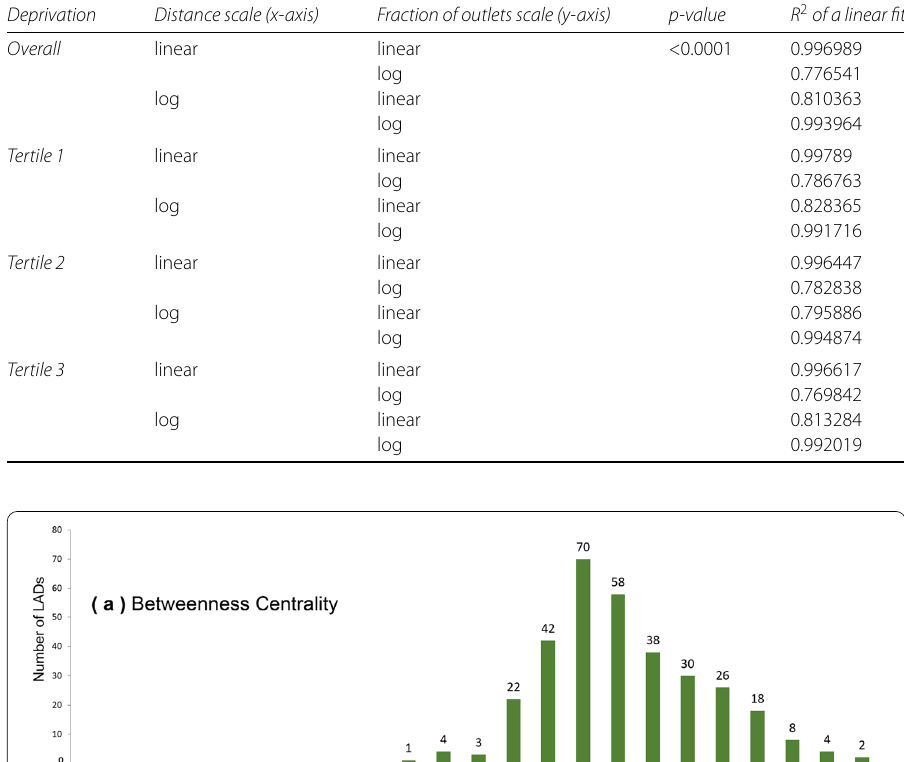
Table 6 Fits across levels of deprivation and scaling of the axes Deprivation Distancescale(x-axis) Fractionofoutletsscale(y-axis) p-value R 2 ofalinearfit Overall linear linear <0.0001